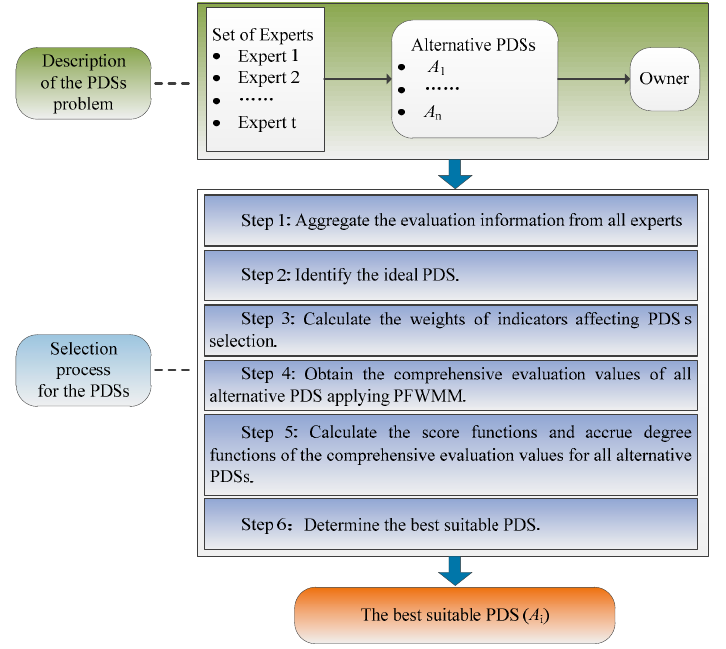
Figure 2. The selection process for PDSs.